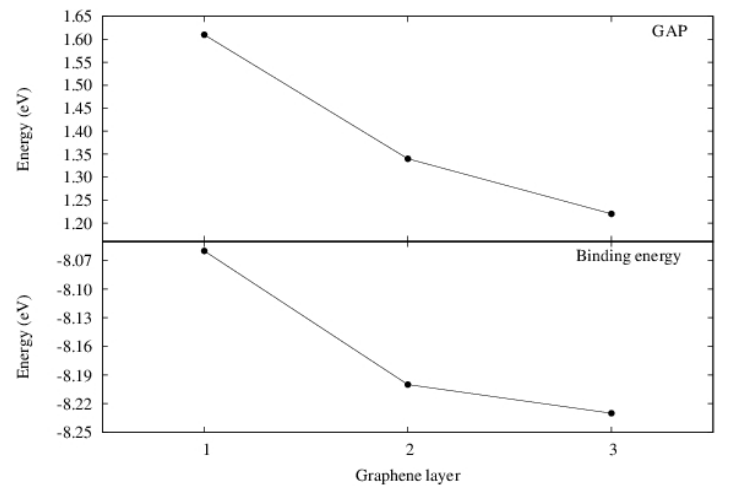
Figure 7: GAP and binding energies of graphene-like structures composed by different numbers of graphene